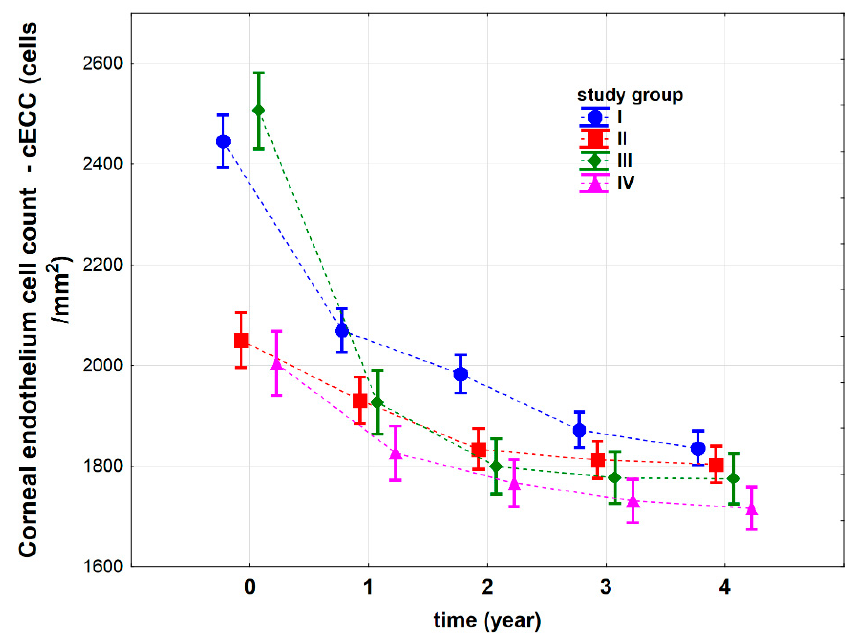
Figure 4. Corneal endothelium cell count (cECC) (cells/mm 2 ) before (t 0 ) and after iris-claw Artisan intraocular lens (IOL) implantation in four groups of patients: I—patients subjected to complicated cataract surgery, II—patients with postoperative aphakia, III—patients with aphakia subjected to penetrating keratoplasty, IV—patients subjected to pars plana vitrectomy and luxated IOL extraction. Vertical lines represent 95% confidence intervals. For the reader’s convenience, the points relating to individual groups have been joined by a dashed line.